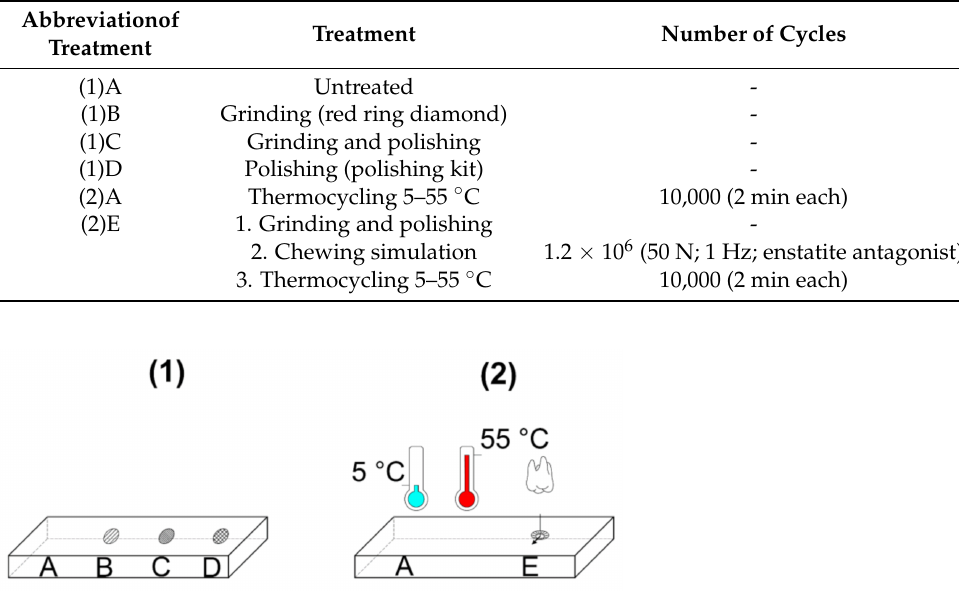
Figure 1. Visualization of the measurement points on the surface of two zirconia specimens for each treatment code (abbreviations in Table 2). ( 1 ): without thermocycling (TC); ( 2 ) with thermocycling (TC) and chewing